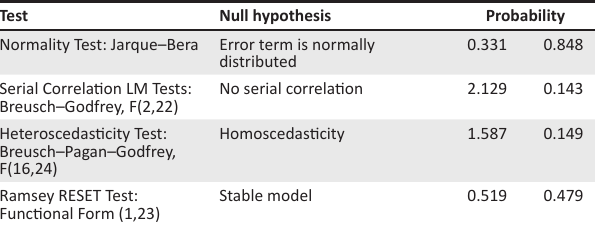
CUSUM 5 % Significance CUSUM of squares 5 % Significance